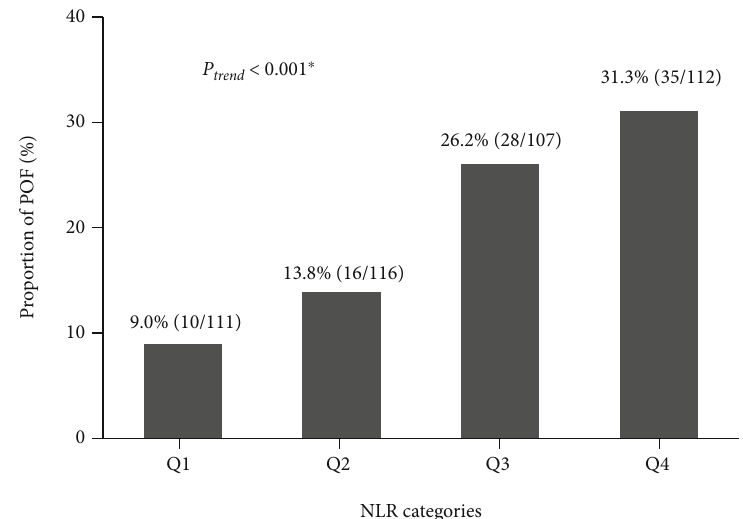
Figure 2: The proportion of POF for the quartiles of NLR at admission. Q1: NLR ≤ 4 : 386 ; Q2: 4 : 386 < NLR ≤ 6 : 563 ; Q3: 6 : 563 < NLR ≤ 10 : 333 ; Q4: NLR > 10 : 333 . ∗ The Linear-by-Linear Association test for the POF trend was signi fi cant. NLR: neutrophil-lymphocyte ratio; POF: persistent organ failure.